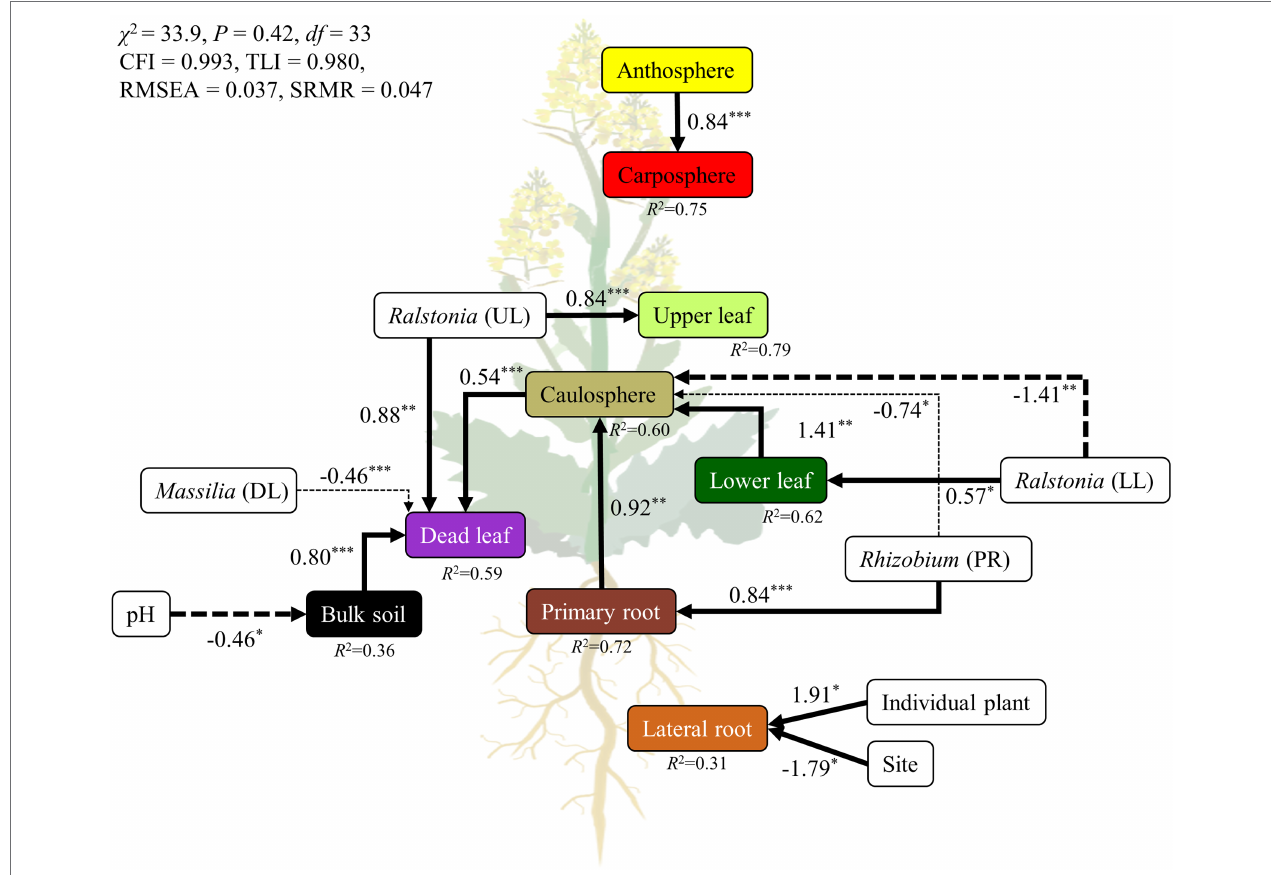
FIGURE 6 | Structural equation model (SEM) showing the relationships among holobiont components, environmental factors, and representatives groups of bacteria. The solid arrows represent the positive effects, while dotted arrows represent the negative effects. The width of the arrows indicates the strength of the effect. *** p < 0.001; ** p < 0.01; * p <